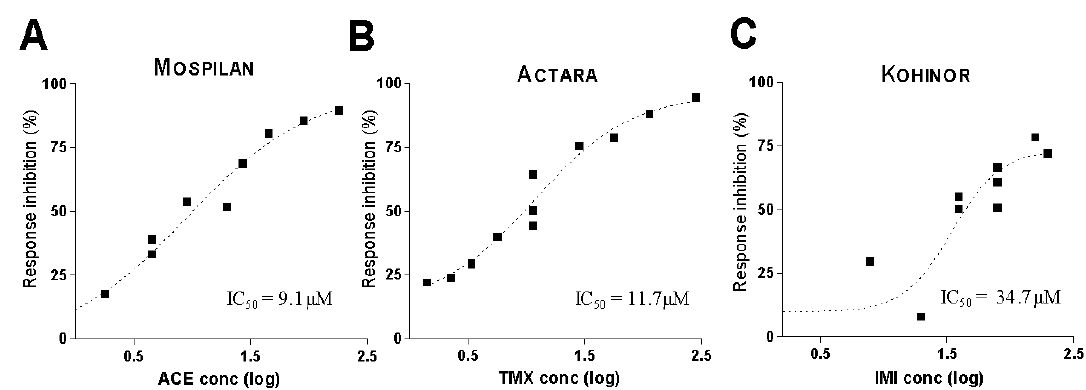
Figure 8. Dose-response analysis of neonicotinoid effects showing M OSPILAN (A), A CTARA (B) and K OHINOR (C) all inhibiting the ACh-evoked inward currents. X axis: amplitude values in percentage of the control response. Y: Log concentrations of insecticides in molarities of their active components.